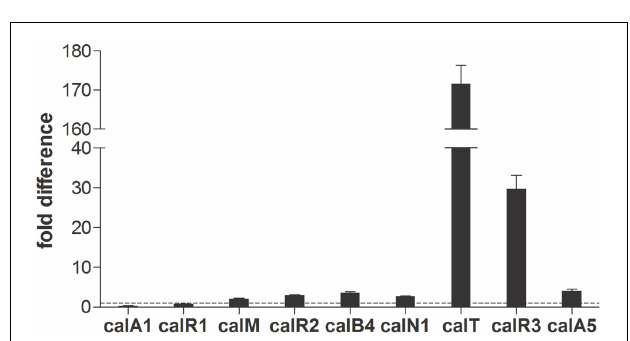
FIGURE 3 | Transcriptional analysis of the cal genes. Real-time RT-PCR analysis of cal genes transcription levels in GLX-26 and the wild type strain for 96 h